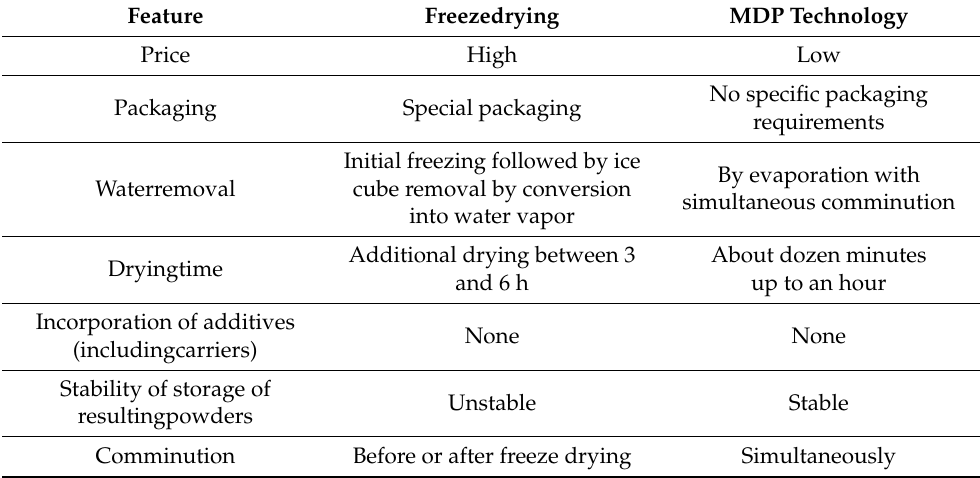
Table 1. Comparison of freeze drying and MDP [28–31]. Feature Freezedrying MDP